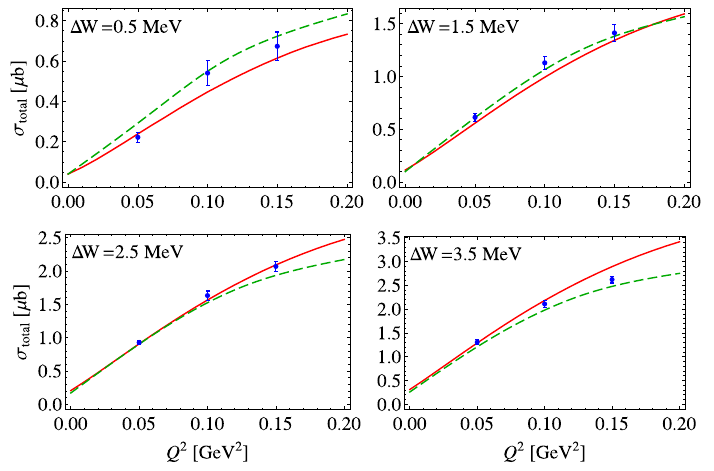
Figure 2. Total cross sections in (cid:5) b as a function of Q 2 for different cm energies above threshold (cid:5) W in MeV. The data are from Ref.